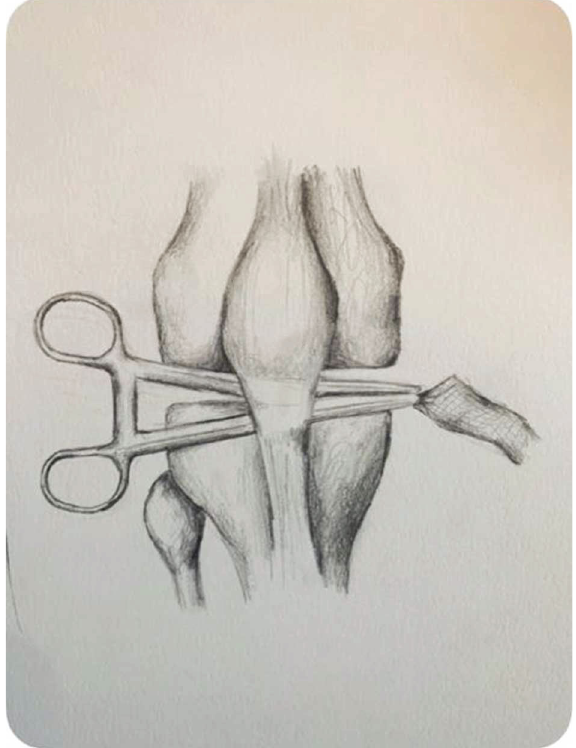
Figure 6: Illustration of passage of mesh through created patellar tunnel.